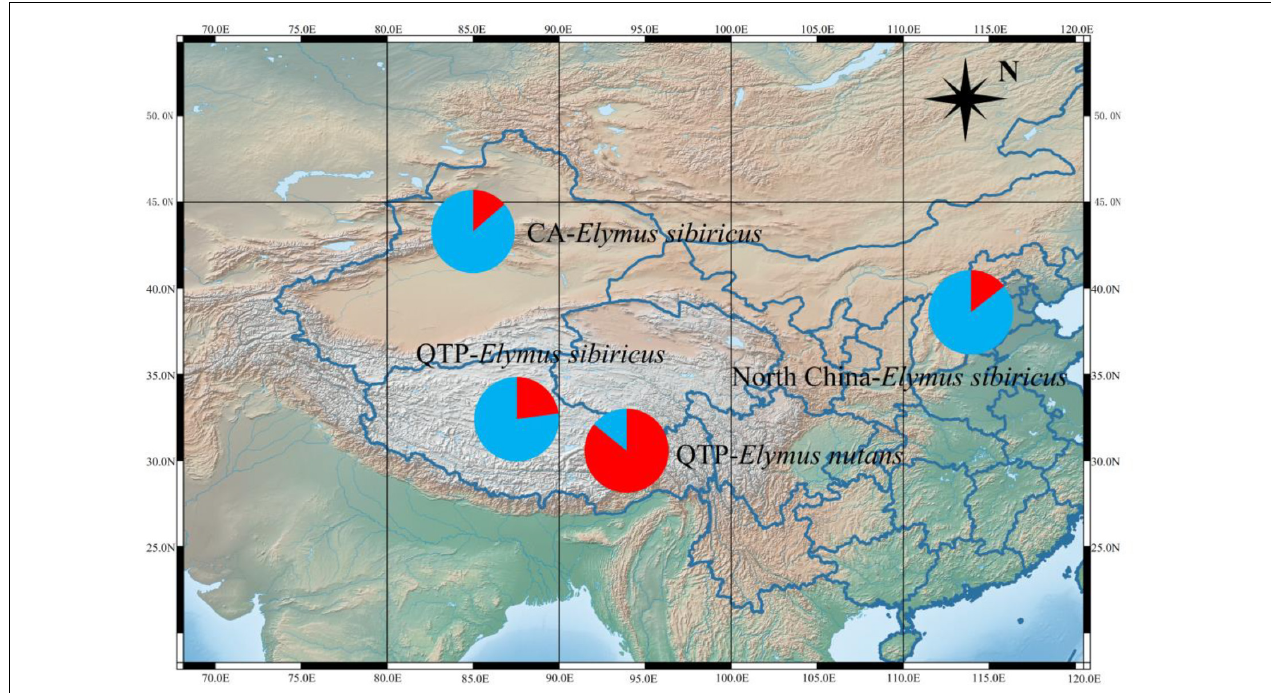
FIGURE 9 | STRUCTURE analysis revealing the genetic affiliations of 60 E. sibiricus and 32 E. nutans accessions. The red and blue colors indicate the different genetic